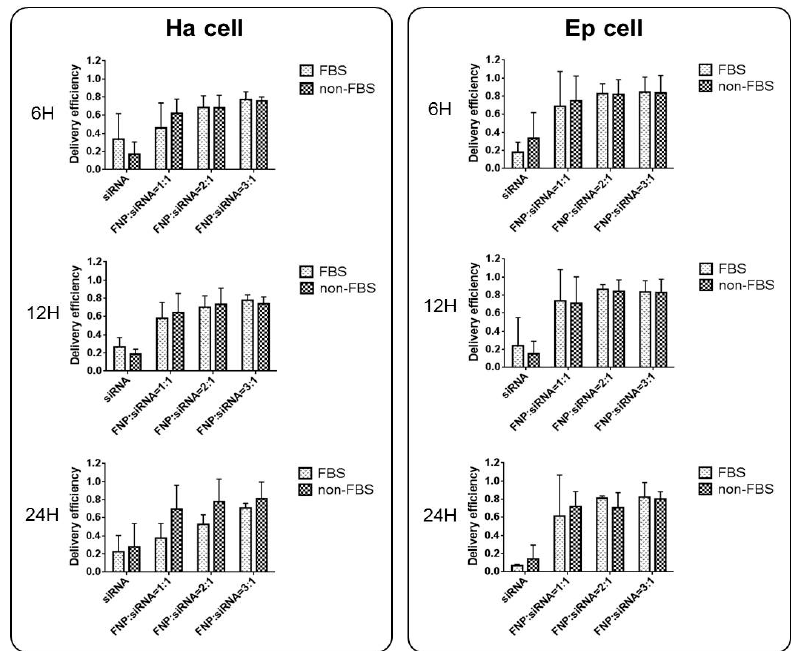
Figure 3. Effect of serum (FBS) on siRNA delivery efficiency in Ha and Ep cells. siRNA and FNP were incubated in a cell culture medium containing 5% FBS during siRNA delivery in vitro. For non-FBS cell groups, siRNA and FNP were incubated in a cell culture medium without FBS. siRNA delivery efficiency between FBS and non-FBS cell groups was not significantly different. The delivery efficiency was calculated as the percentage of fluorescent cells to total